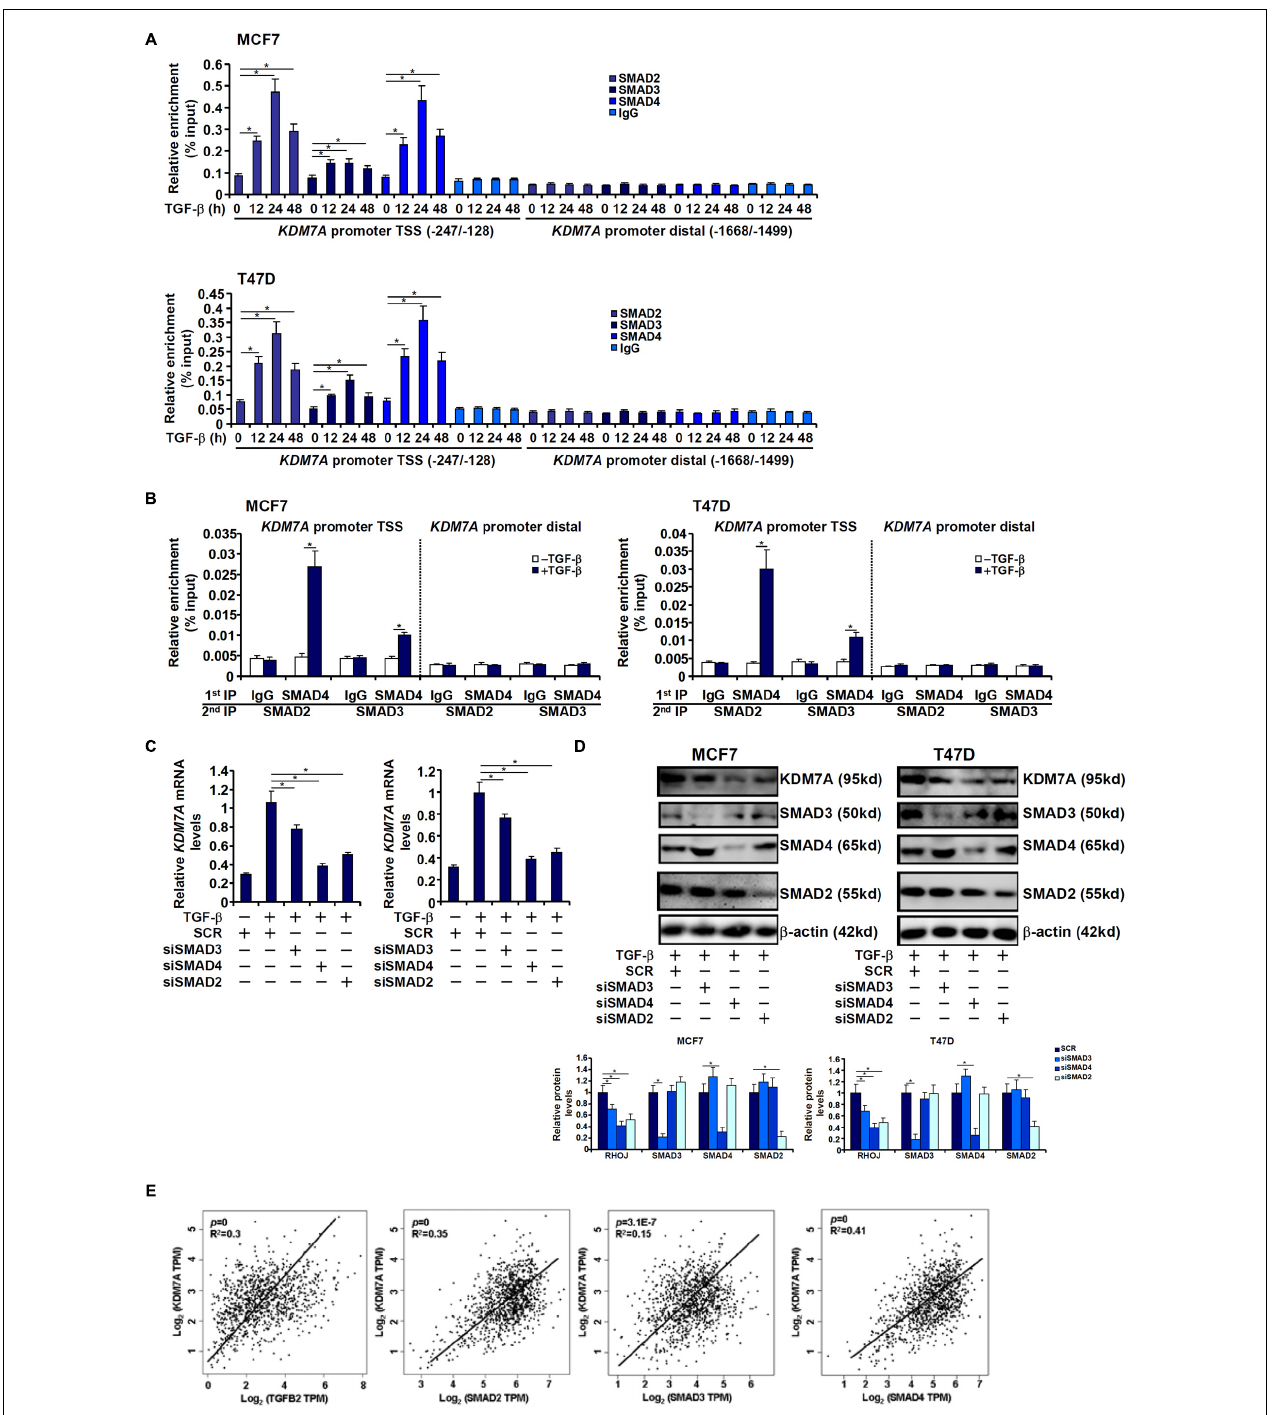
FIGURE 7 | SMAD2/SAMD4 complex mediates transcriptional activation of JHDM1D/KDM7A in breast cancer cells. (A) MCF7 (left panel) and T47D cells (left panel) were treated with TGF- β and harvested at indicated time points. KDM7A expression was examined by qPCR and Western blotting. ChIP assay was performed with anti-SMAD2, anti-SMAD3, anti-SMAD4, or IgG. (B) MCF7 (left panel) and T47D cells (left panel) were treated with TGF- β and harvested at indicated time points. KDM7A expression was examined by qPCR and Western blotting. Re-ChIP assay was performed with indicated antibodies. (C,D) MCF7 (left panel) and T47D cells (left panel) were transfected with siRNAs targeting SMAD or scrambled siRNA followed by treatment with TGF- β . KDM7A expression was examined by qPCR and Western blotting. All experiments were performed in triplicate wells and repeated three times, and one representative experiment is shown. Data represent mean ± SD. * p < 0.05, two-tailed t -test. (E) Expression data were extracted from the public database to draw the scatter plot. Pearson correlation coefficient was calculated. Positive correlation between KDM7A expression and SMAD2/3/4 expression was identified in human breast cancer tissues.